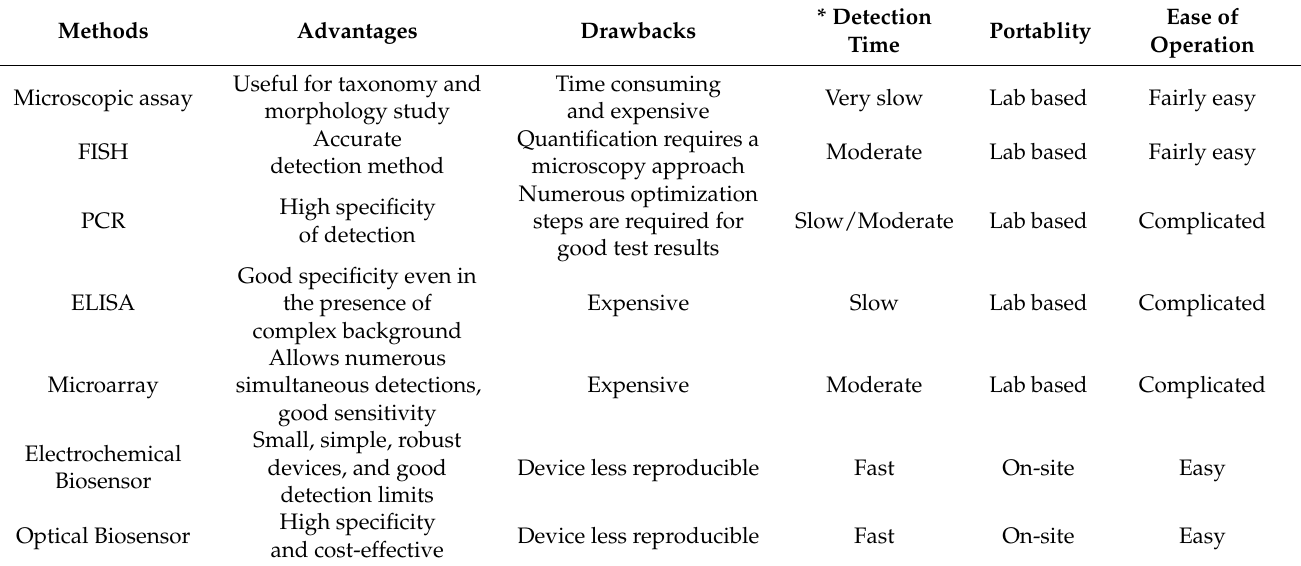
Table 4. General comparison of biosensor and conventional methods in HAB